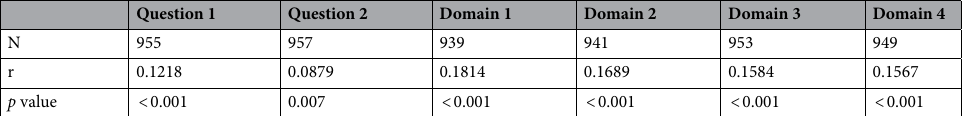
Table 5. Correlation coefficients r between changes in WHOQOL-BREF scores and the difference in Mg level in women with hormone-related conditions (N = 957). Mg magnesium; WHOQOL - BREF World Health Organization quality of life questionnaire; p values reflect whether Pearson’s coefficient of correlation is statistically significant between changes in WHOQOL-BREF question/domain scores and the difference in serum Mg